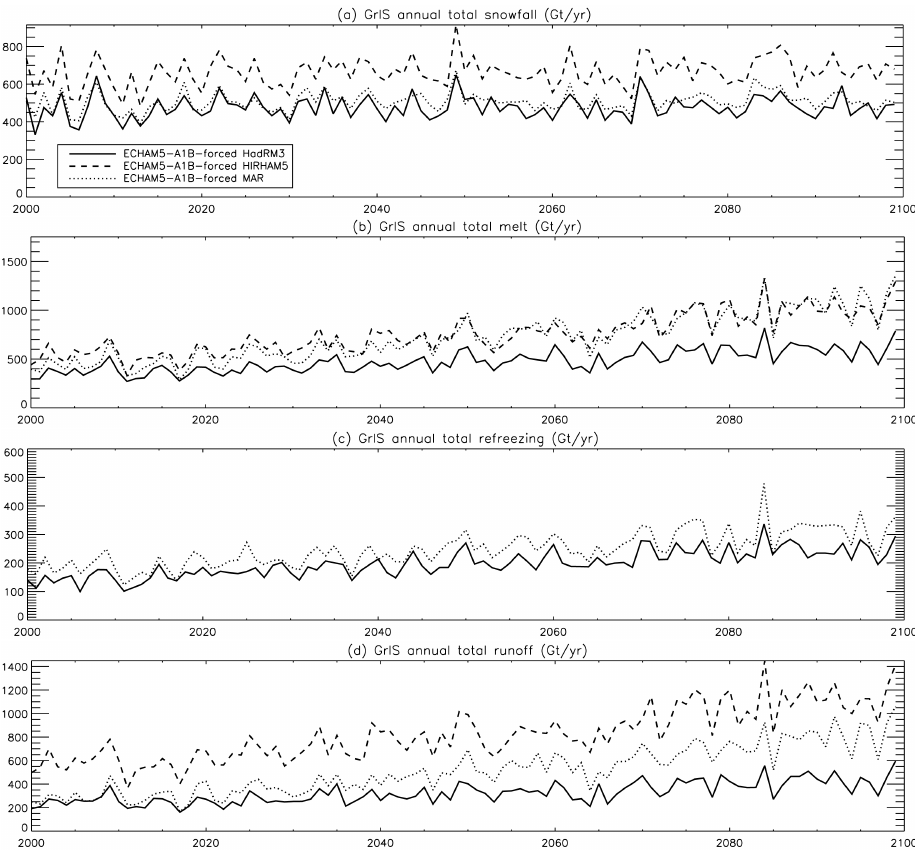
Fig. 13. Time series of GrIS annual total: (a) snowfall, (b) melt, (c) refreezing, and (d) runoff, all in Gtyr − 1 , for the three RCMs, forced by ECHAM5-A1B boundary conditions. Refreezing is not output in HIRHAM5. The HadRM3P refreezing was calculated offline.